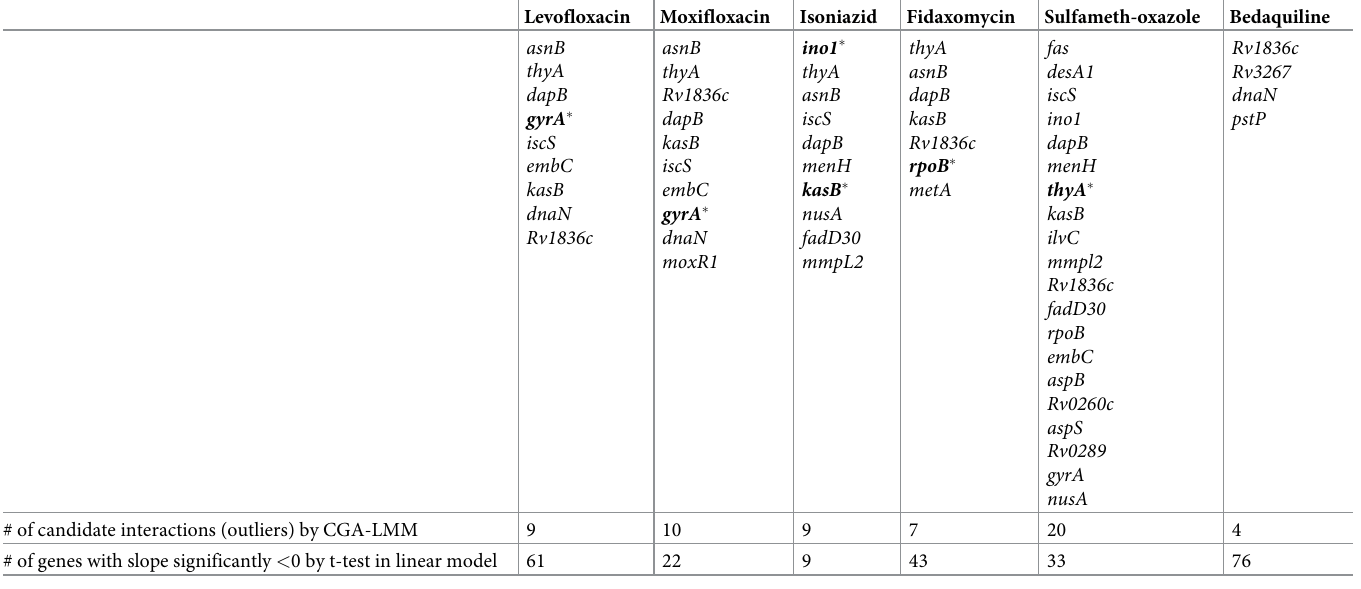
Table 3. Interacting genes (with negative outlier slopes, Zrobust < -3.5) for six anti-tubercular drugs, out of a hypomorph library with 162 genes, ranked in order of most negative slope at the top.